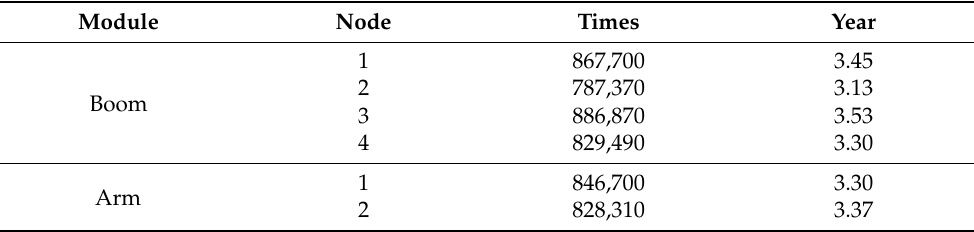
Table 7. The fatigue life of the crisis nodes on the remanufactured excavator beam. Module